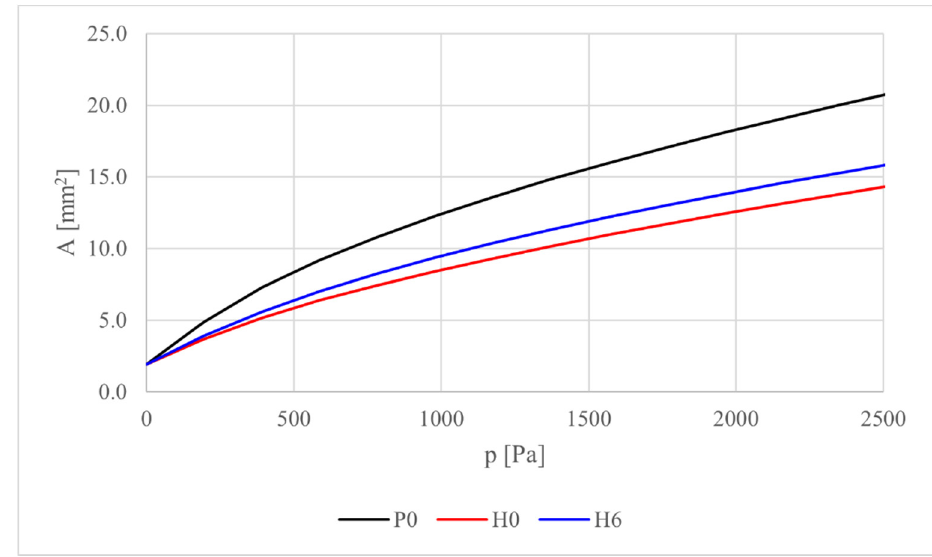
Figure 6. Variation of the lumen area for configurations P0, H0, and H6 with respect to the intraluminal pressures. Table 4. Pre- and post-operative patients’ characteristics.